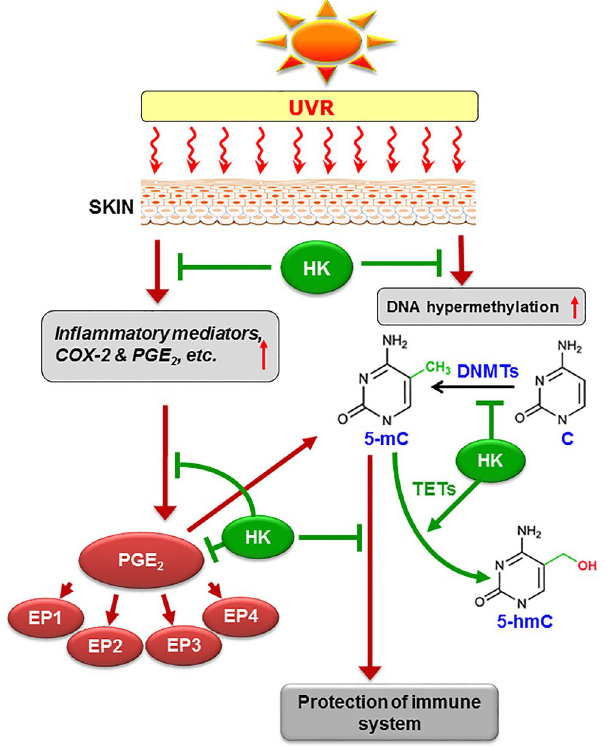
Figure 7. Schematic diagram depicts a crosstalk between UV radiation-induced inflammatory mediators and epigenetic regulators (DNA hypermethylation). UVB-induced photodamage initiates the generation of inflammatory mediators and enhancement in DNA methylation in skin cells. Inflammatory mediators and DNA hypermethylation play critical roles in suppression of immune system in UV-exposed mice. Topical application of honokiol inhibits UVB-induced inflammation as well as DNA hypermethylation through TET- mediated demethylation of DNA, and that results in restoration or protection of immune system in UVB- exposed mouse skin. HK, honokiol; 5mC, 5-methylcytosine; 5-hmC, 5-hydroxymethylcytosine; TET, ten eleven